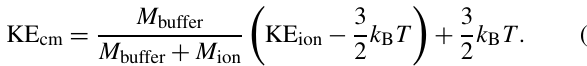
(cid:113) (H 2 O) reagent 4